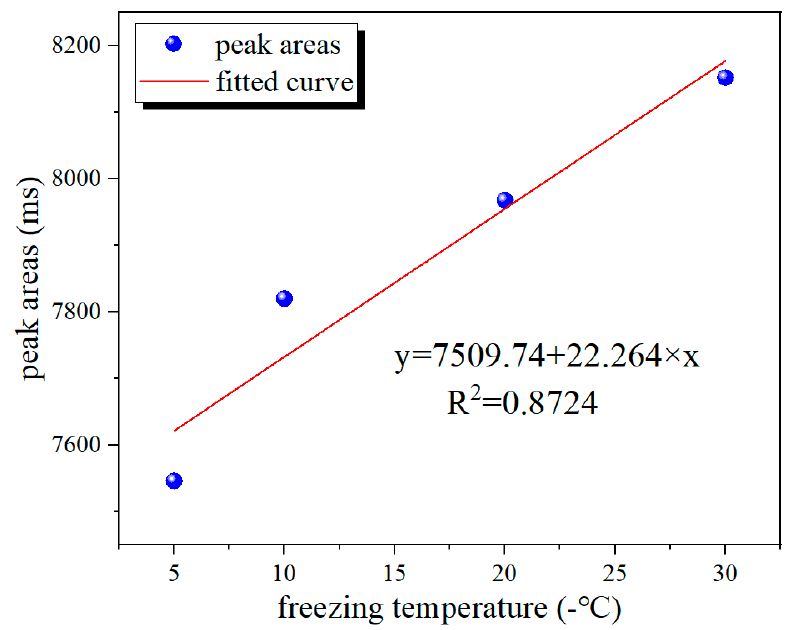
Figure 5. The curve of relation between freezing temperature and peak area of thawed soils.